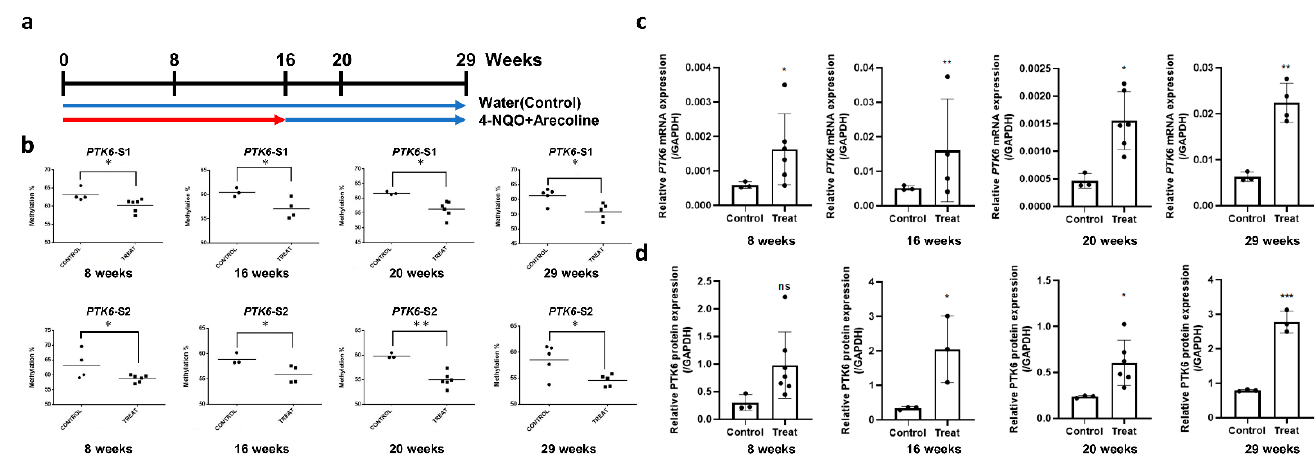
Figure 2. PTK6 hypomethylation induces OSCC carcinogenesis by increasing PTK6 transcriptional expression in the animal model. ( a ) Flowchart of exposure of mice to carcinogens (200 µg/mL of 4-NQO and 500 µg/mL of arecoline) in drinking water. The mice treated with 4-NQO and arecoline and corresponding control mice were sacrificed at 8, 16, 20, and 29 weeks for analysis. ( b ) Methylation analysis of PTK6 in the tongue tissues of OSCC mice at different time points. ( c ) PTK6 transcriptional expression in the tongue tissues of the OSCC mice at different time points. ( d ) The protein expression of PTK6 in the tongue tissues of the OSCC mice at different time points. * p < 0.05. ** p < 0.01; *** p < 0.005.